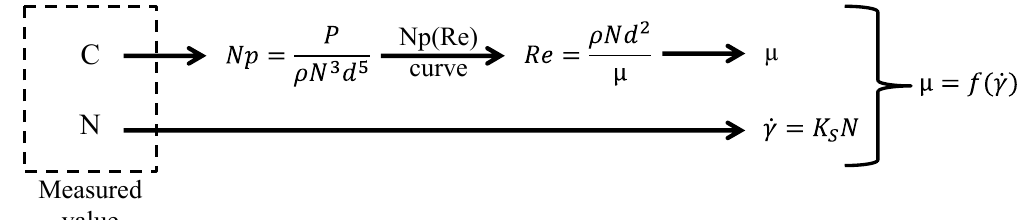
Figure 1. In-situ rheometry calculation principle.